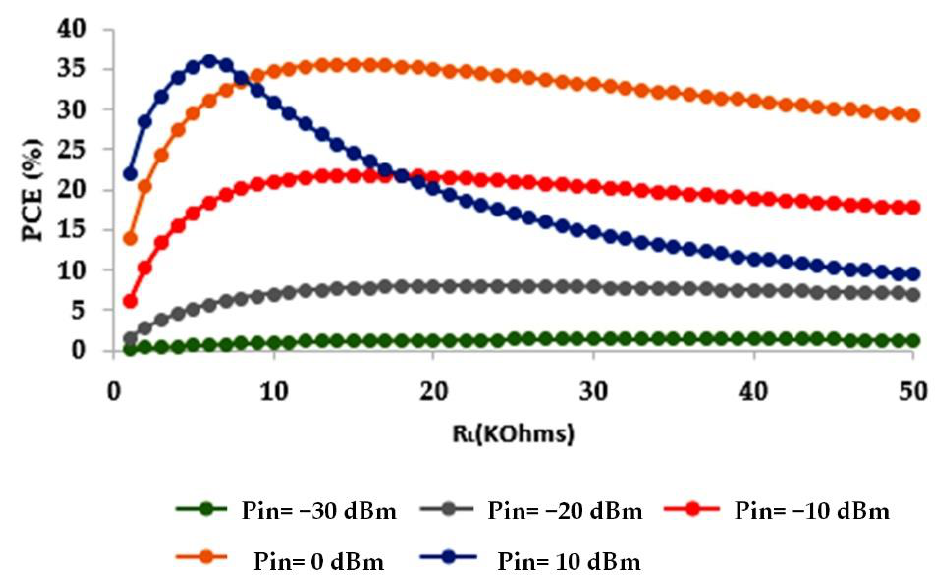
Figure 13. The change of PCE depends on different output loads.